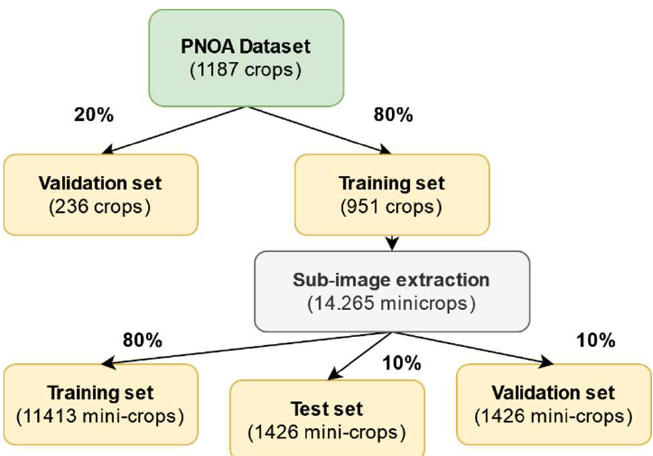
Figure 4. Description of the dataset division for the training and validation sets.